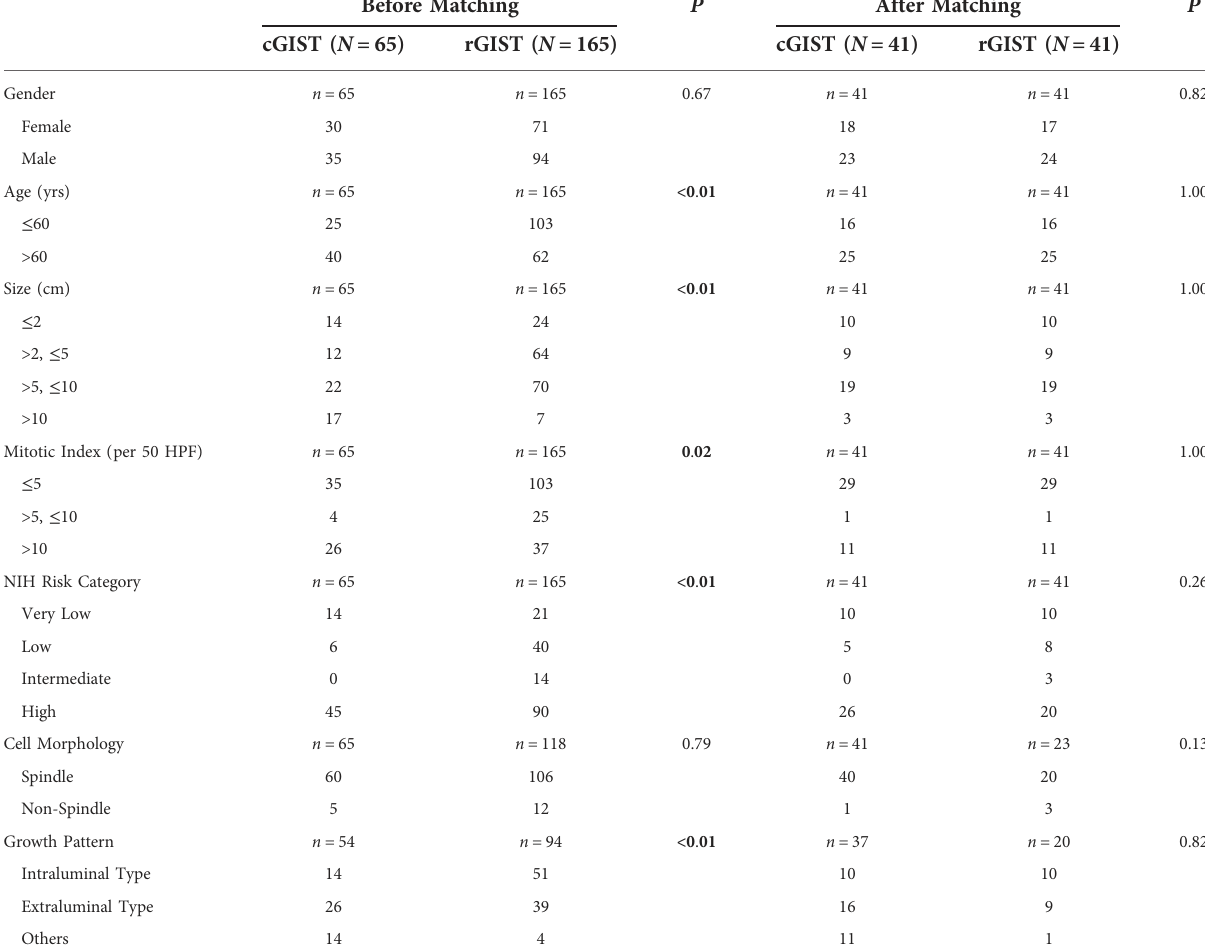
TABLE 1 Patient baseline characteristics and tumor features in unmatched and matched cohorts. Before Matching After Matching